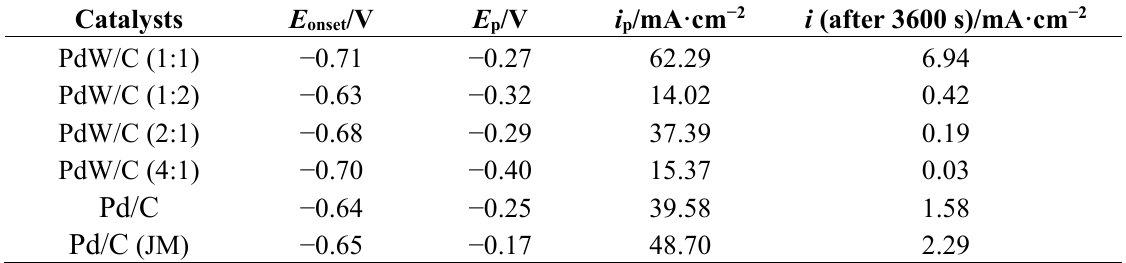
Figure 3. Voltammetric curves of PdW/C (1:1) and Pd/C in 1 M KOH solution at 50 mV·s − 1 . Table 2. Comparison of electrochemical performances on the prepared Pd-based